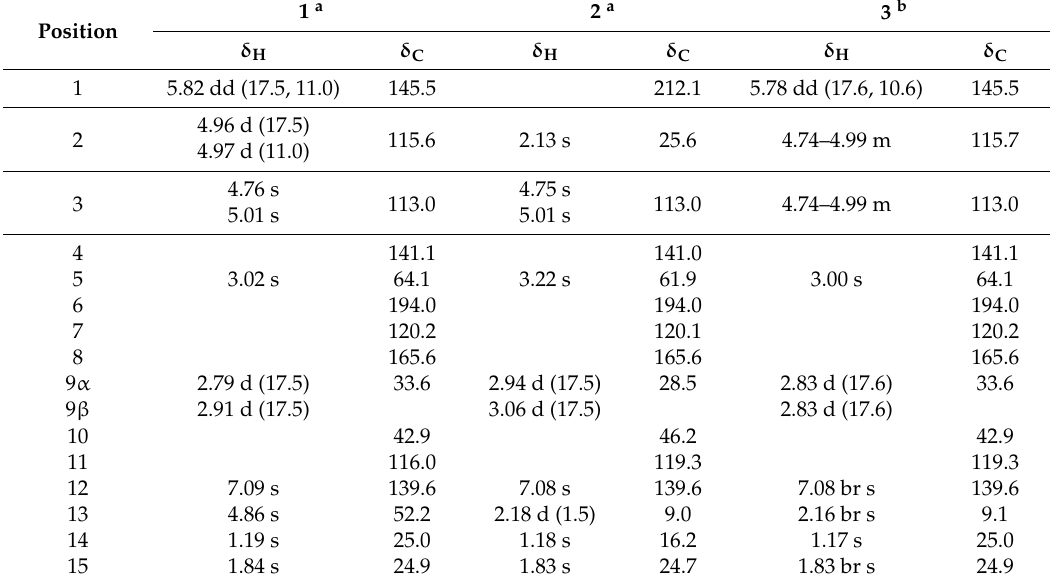
Table 1. 1 H- and 13 C-NMR data of 1 – 3 .